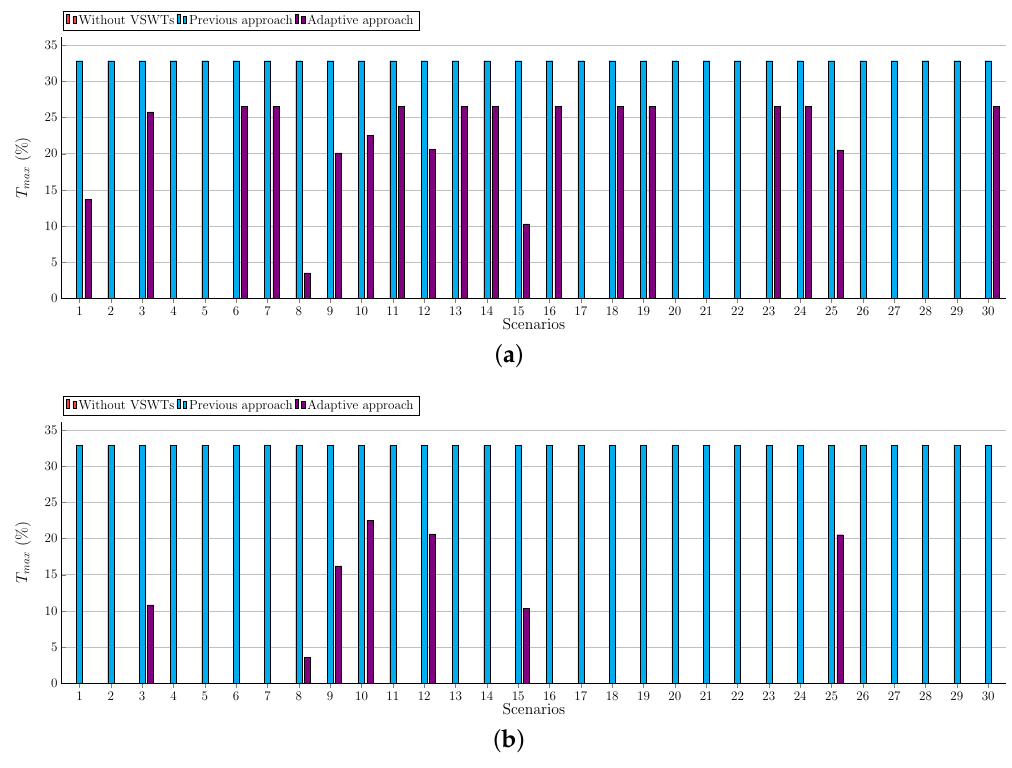
Figure 10. Maximum torque variation ( a ) Largest power plant disconnection; ( b ) Second largest power plant